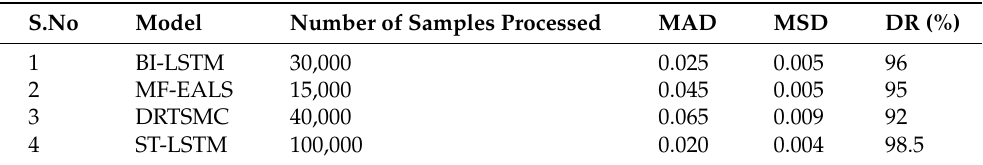
Table 6. Comparison of various data recovery